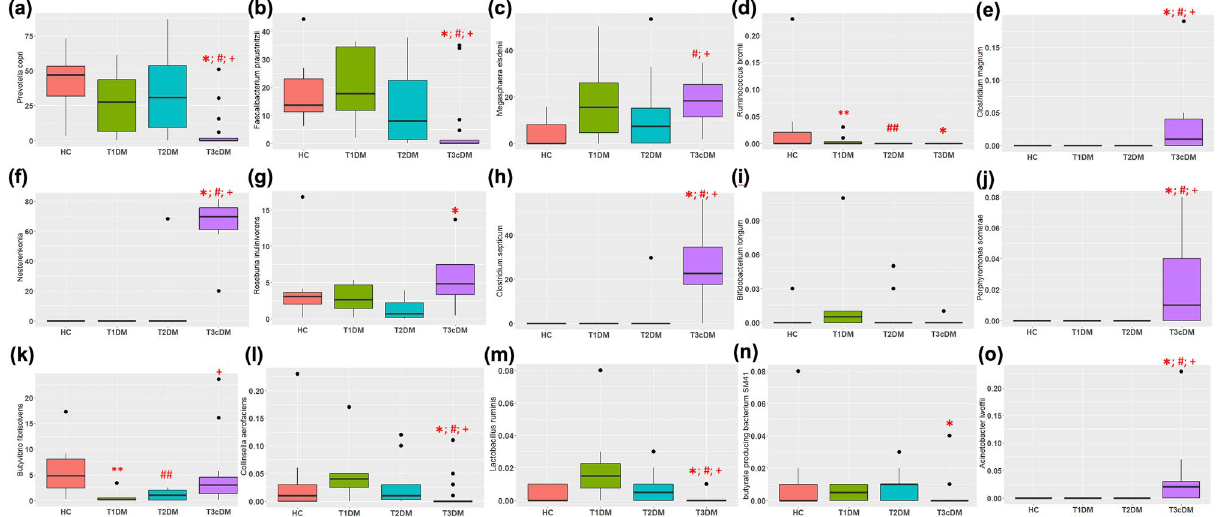
Figure 6. Relative abundances of top 15 species showing the most significant differences. Box and whisker plots depicting relative abundance of ( a ) Prevotella copri ; ( b ) Faecalibacterium praustnitzii ; ( c ) Megasphaera elsdenii ; ( d ) Ruminococus bromii ; ( e ) Clostridium magnum ; ( f ) Nesterenkonia.sp AN1 ; ( g ) Roseburia inulivorans ; ( h ) Clostridium septicum ; ( i ) Bifidobacterium longum ; ( j ) Porphyromonas somerae ; ( k ) Butyrivibrio fibrisolvens ; ( l ) Collinsella aerofaciens ; ( m ) Lactobacillus ruminis ; ( n ) Butyrate producing bacteria SM41 ( o ) Acinetobacter lwoffi . * indicates statistically significant difference between healthy control and T3c diabetes; ** between healthy controls and Type 1 diabetes, # between Type 1 and Type 3c diabetes, ## between healthy control and Type 2 diabetes, and + between Type 2 and Type 3c diabetes. Refer to Supplementary Table 6 for exact p